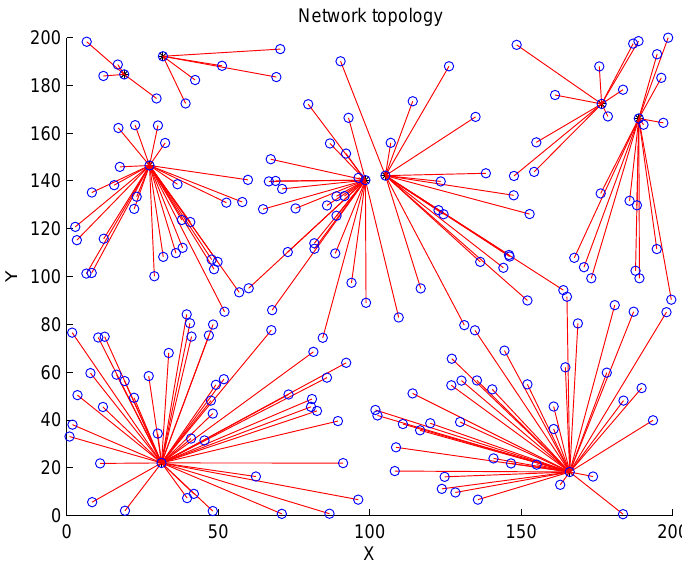
Figure 10. Cluster formation of